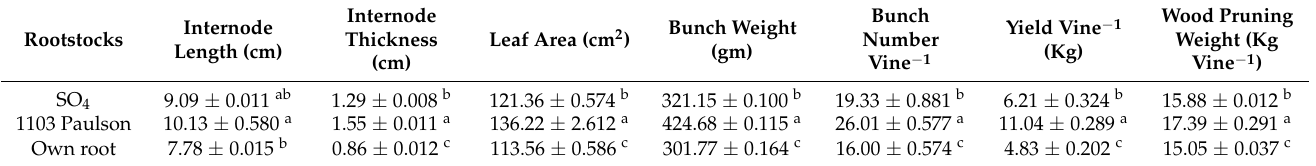
Table 6. The different between rootstocks of “Superior seedless” vine on growth and properties of selected bunches at harvest time.